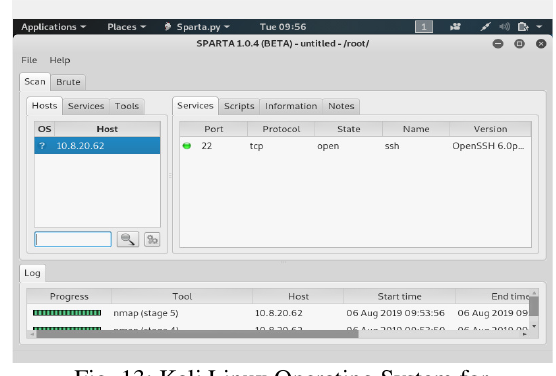
Fig. 13: Kali Linux Operating System for implementing attacks on Hosts